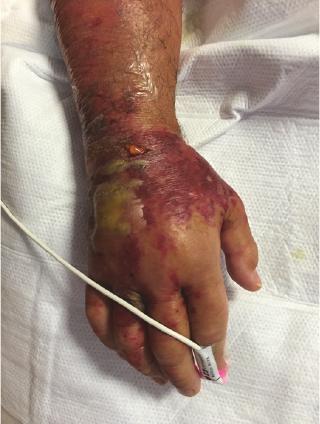
Figure 5: Worsening of skin and soft tissue changes on day 5 after initial